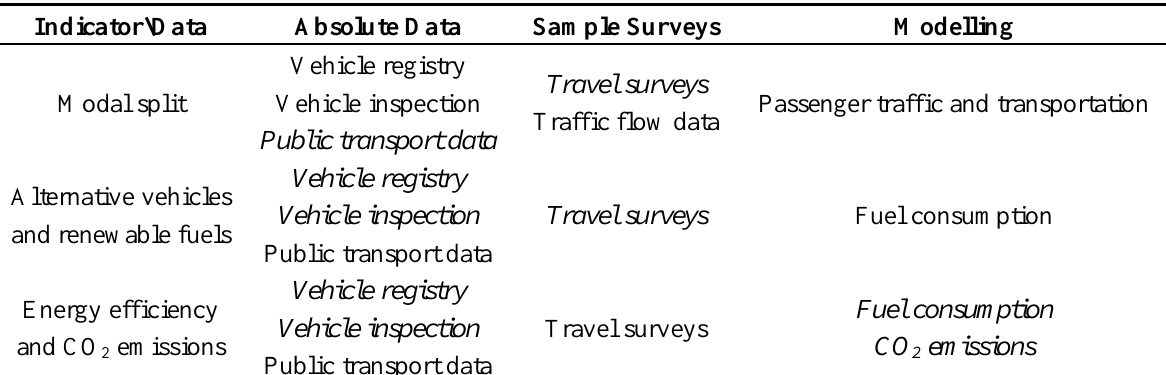
Table 3. Main data sources for different categories of indicators. The most suitable data source for each transport indicator is indicated in